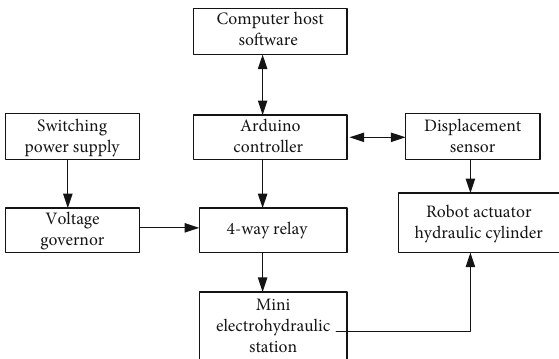
Figure 12: Hardware diagram of hydraulic robot control experimental system.